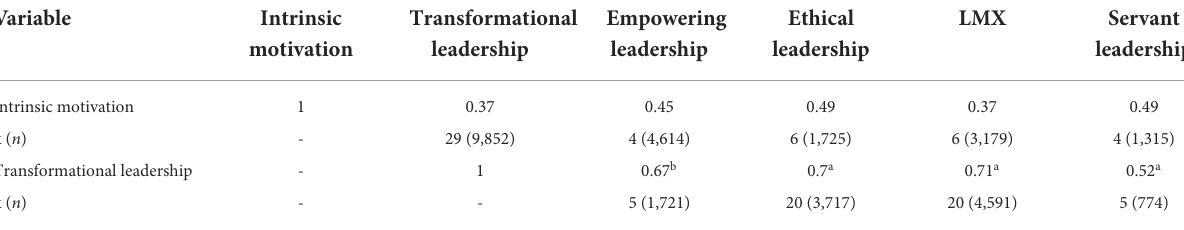
TABLE 4 Meta-analytic correlation matrix.